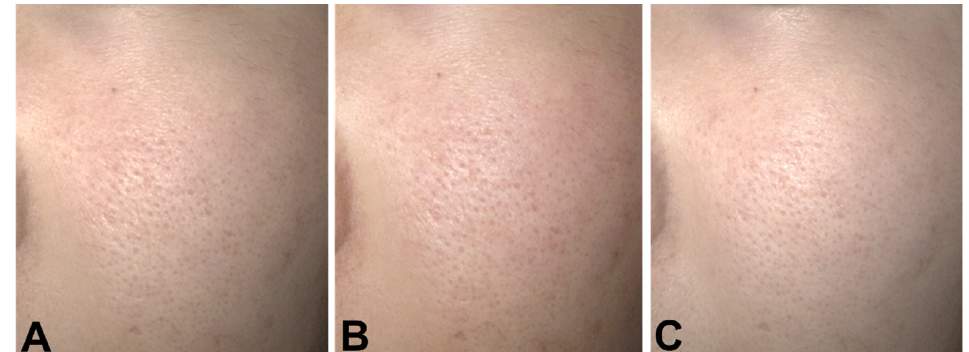
Figure 3. Effects of moisturization on the Δ fluctuation in skin hydration ( A ), Δ fluctuation in TEWL ( B ), Δ fluctuation in pore size ( C ), and Δ fluctuation in redness ( D ). *; p < 0.05. **; p < 0.01.